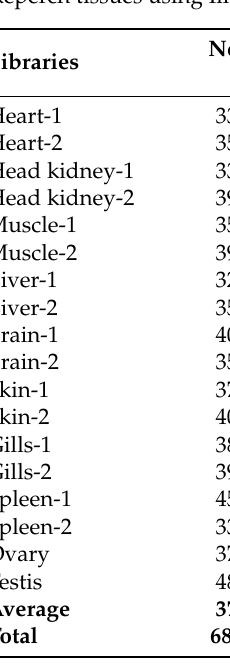
Table 1. Summary statistics of paired-end RNA-Seq reads yielded from 18 libraries of ten different pikeperch tissues using Illumina NovaSeq 6000